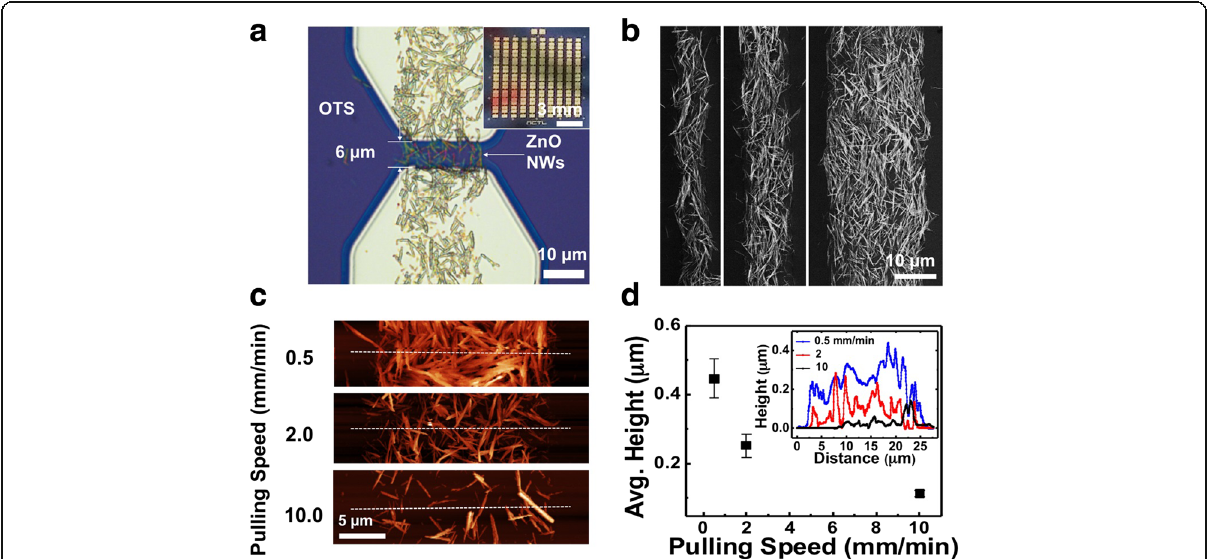
Fig. 2 Channel formation and thickness control of ZnO NW network FET devices. a Magnified optical image of a 6 μ m length NW network channel and Al electrodes. The inset is optical micrograph of 10 × 10 array devices with micro-patterned channels. b Scanning electron microscope (SEM) images showing the selective assembly of ZnO NWs to line patterns with diverse line widths of 5, 10, and 20 μ m. c AFM image of ZnO NWs network. d Average distribution of height vs pulling speed at different pulling speed of 0.5~ 10 mm min − 1 . The inset shows the AFM